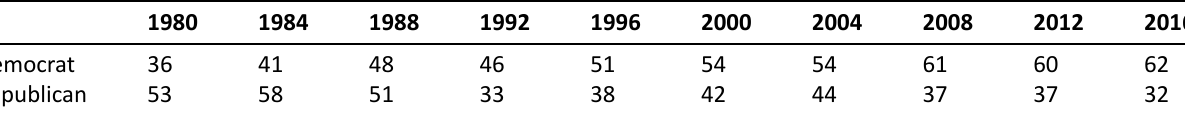
Table 3. California Presidential Voting (%). Source: LA Times. At the same time the state’s electorate has become far more Democratic as shown by its voting in Presidential